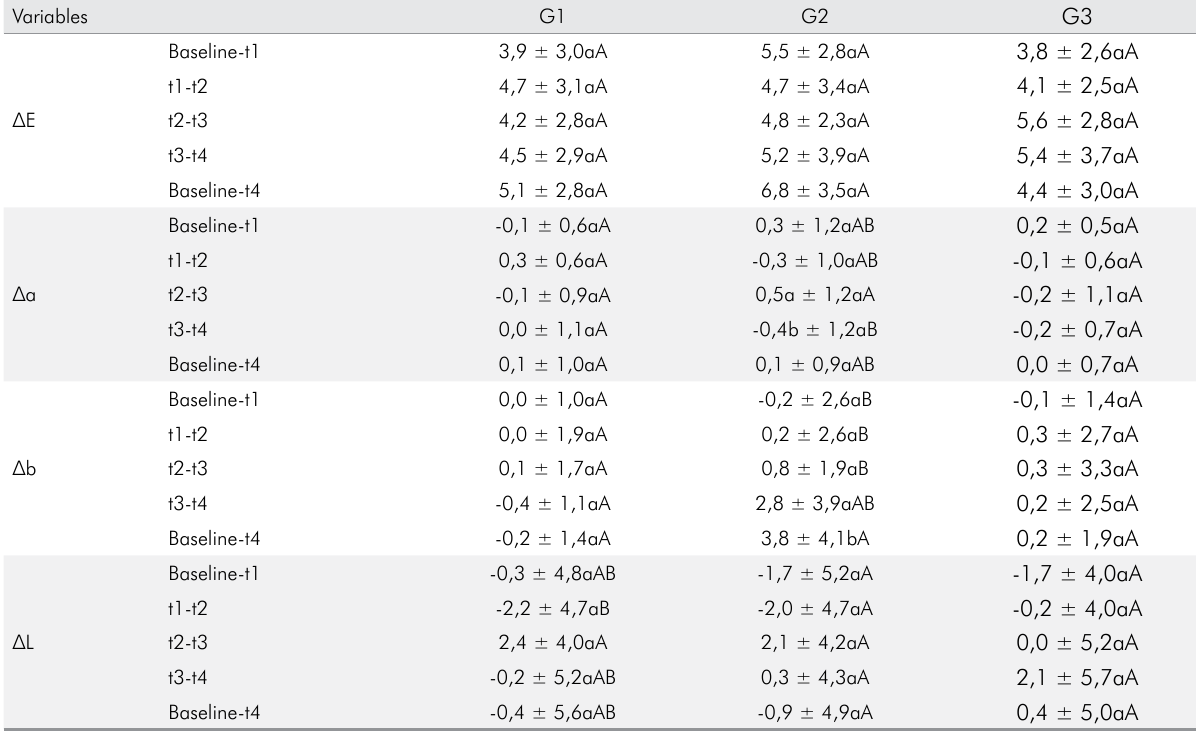
Table 3. Mean values and standard deviation of ∆E, ∆a, ∆b, ∆L for each group.